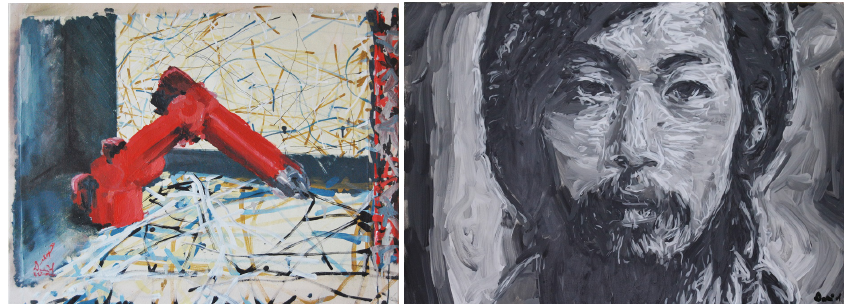
Figure 3. Recent paintings created with